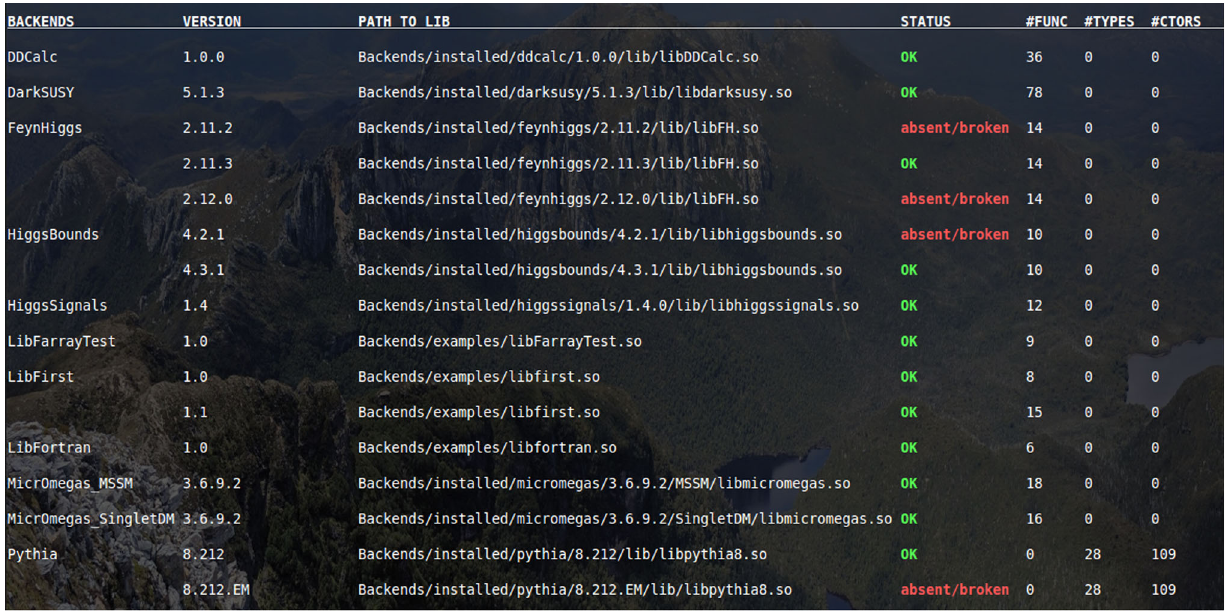
Fig. 7 Example output of the backends diagnostic mode, showing the statuses and locations of different backend libraries configured for use with